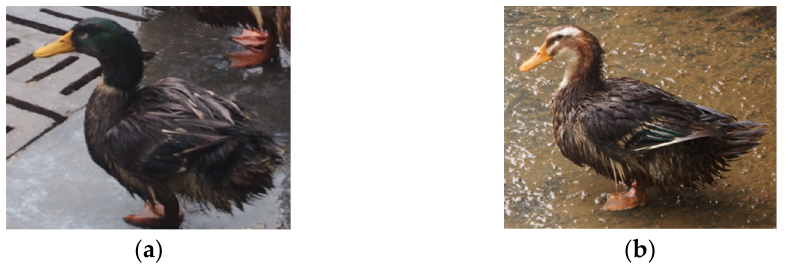
Figure 1. ( a ) The appearance of an average male hemp duck, while ( b ) shows the appearance of an average female hemp duck. Sex differences lead to differences in